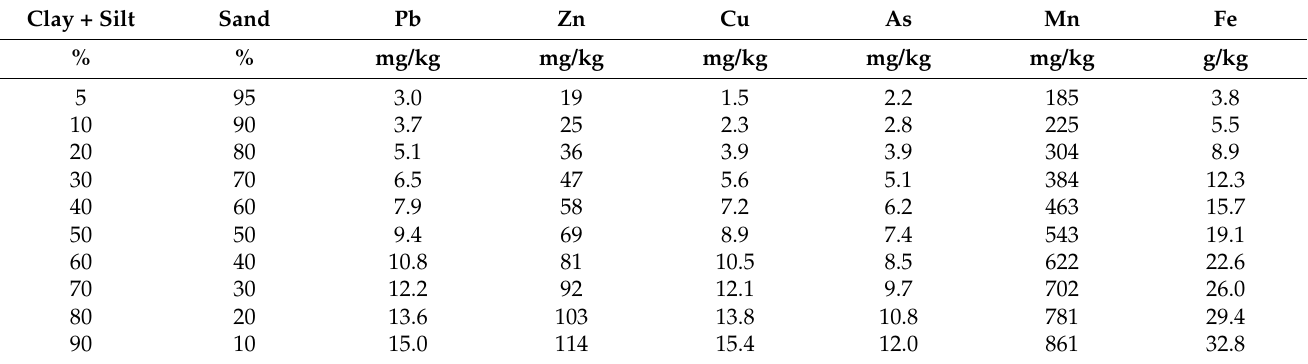
Table 5. Assessed values of geochemical background in alluvial soils of the middle Odra valley as related to soil texture (the sum of clay + silt/or sand